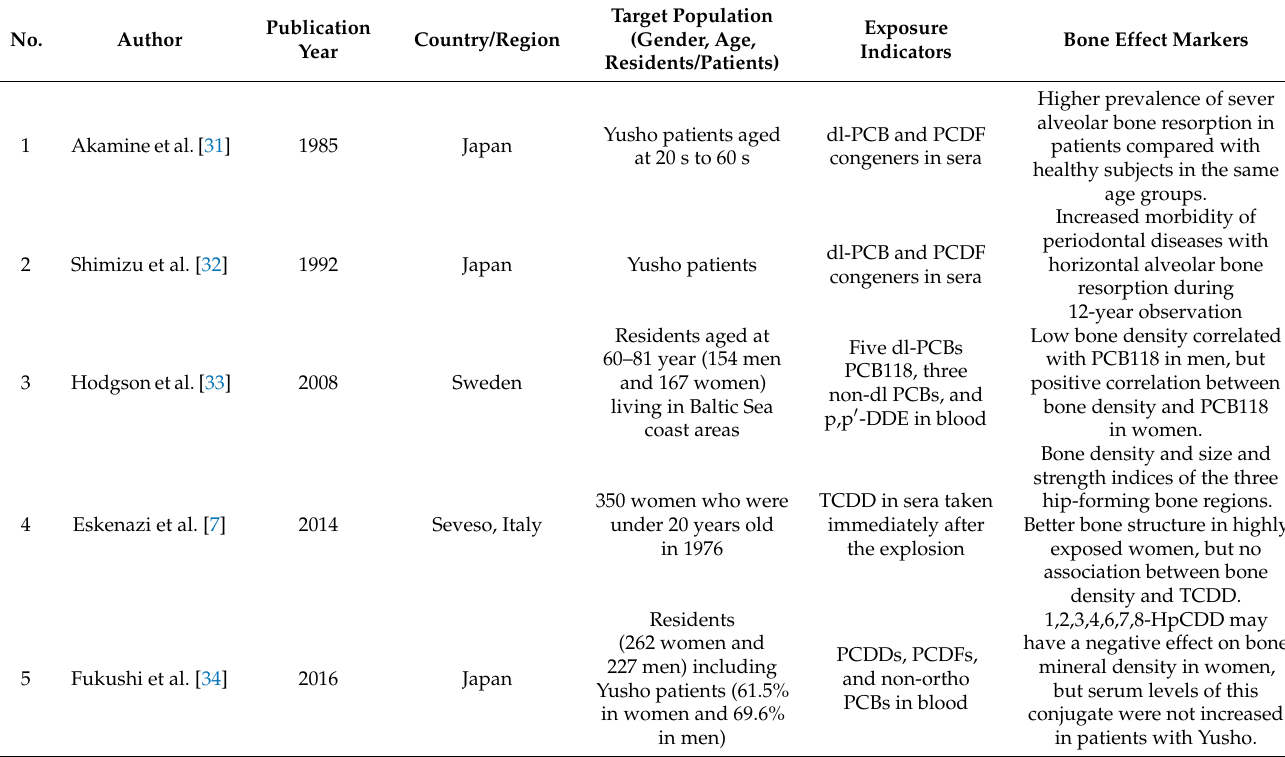
Table 4. Effects of dioxins on bones in